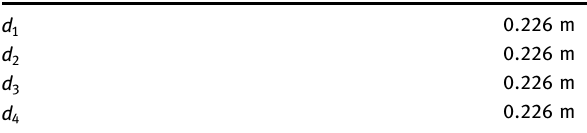
Table 2: Known nominal values of dynamic model